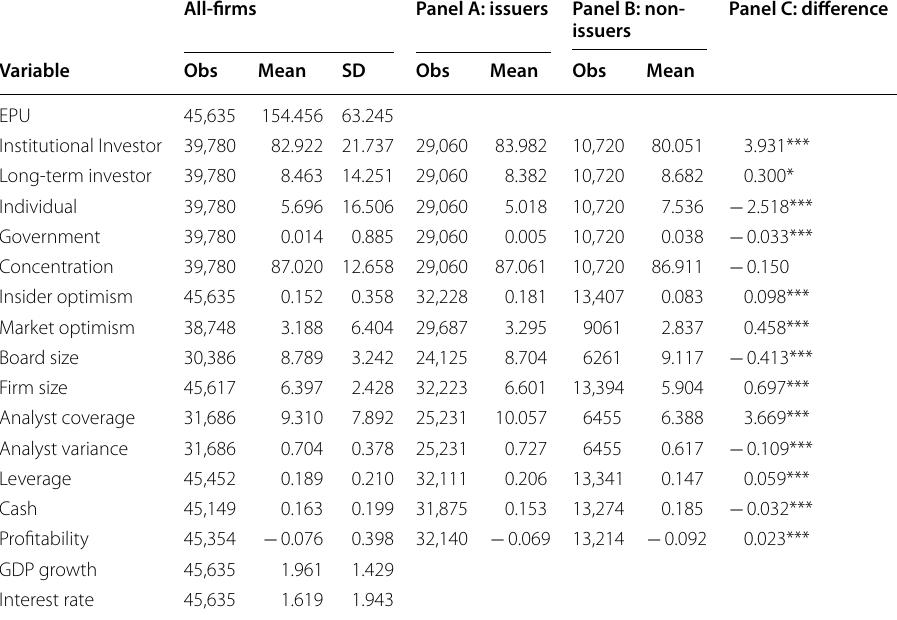
Panel A shows the summary statistics of variables for firms that have raised capital during the sample period. Panel B shows the statistics of variables for firms that did not raise any capital during the sample period. Panel C shows the mean differences of issuer and non-issuer characteristic variables with significance levels *** p < 0.01, ** p < 0.05, * p < 0.1. Mean difference analysis for macroeconomic variables does not apply to individual firms and, consequently, are not presented. Probability of coefficient estimates from the model greater than standard statistics are provided in parentheses. Parentheses contain robust standard error estimates. Asterisks correspond to the outcome of the z-test from the